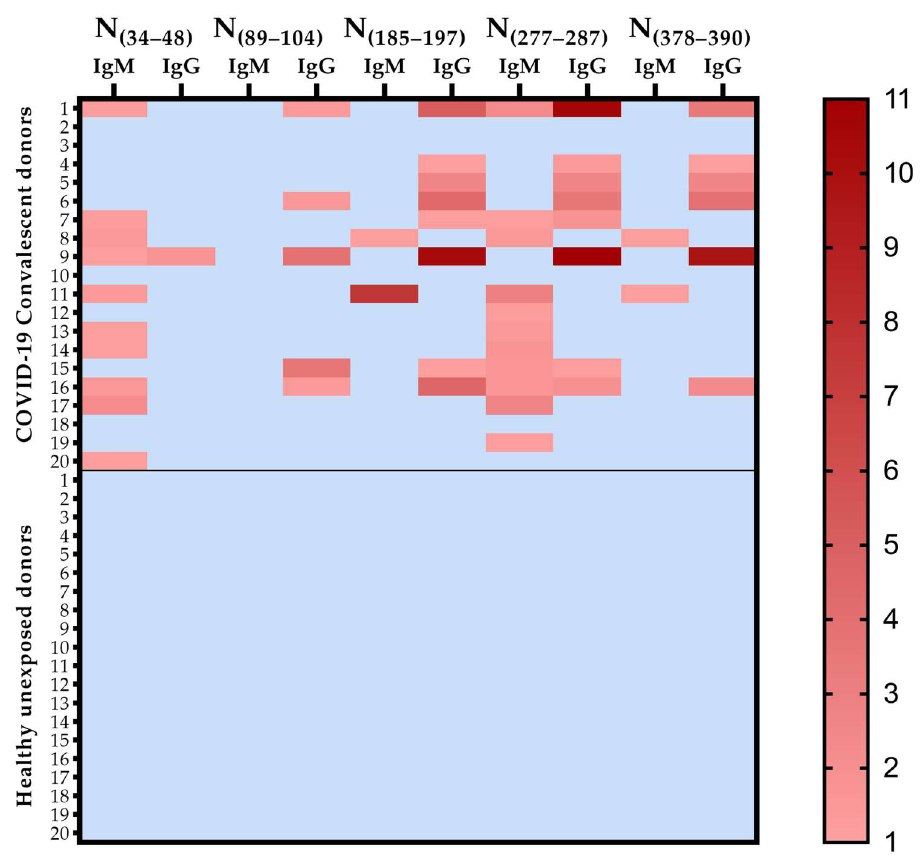
Figure 2. Heatmap of IgM and IgG reactivity indexes against synthetic epitopes. Values higher than 1 represent responder individuals and were indicated in the color scale, and non-responders were indicated by a light blue color.